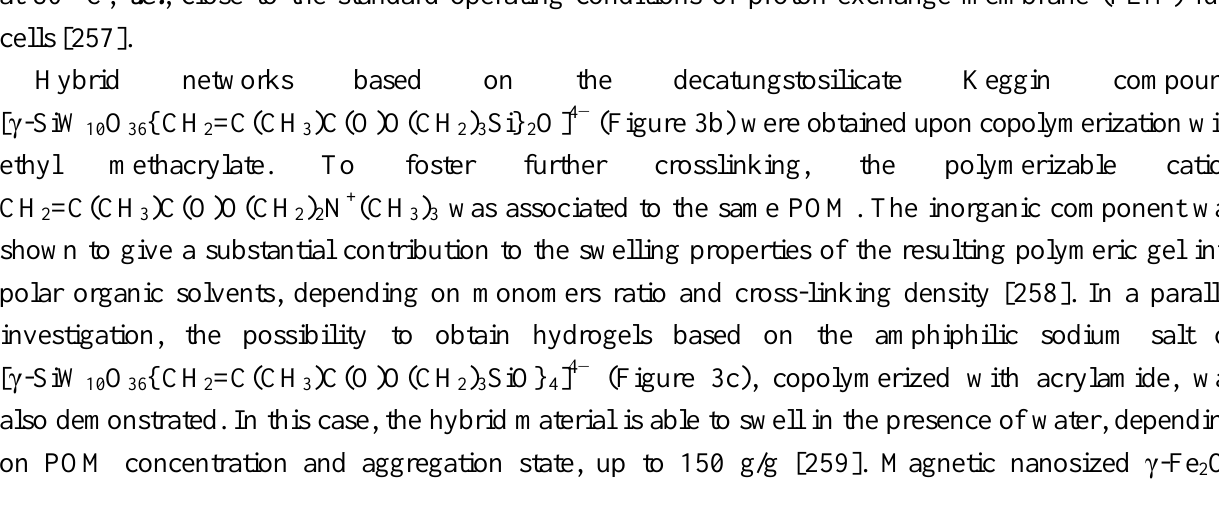
Figure 3. Top: hybrid polyoxotungstates containing polymerizable organosilane pendants: ( a ) bis-(organosilyl) undecatungstosilicate [α-SiW tetrakis(organosilyl) decatungstosilicates [γ-SiW ( d ) tetrakis(organosilyl) nonatungstosilicate [α-SiW